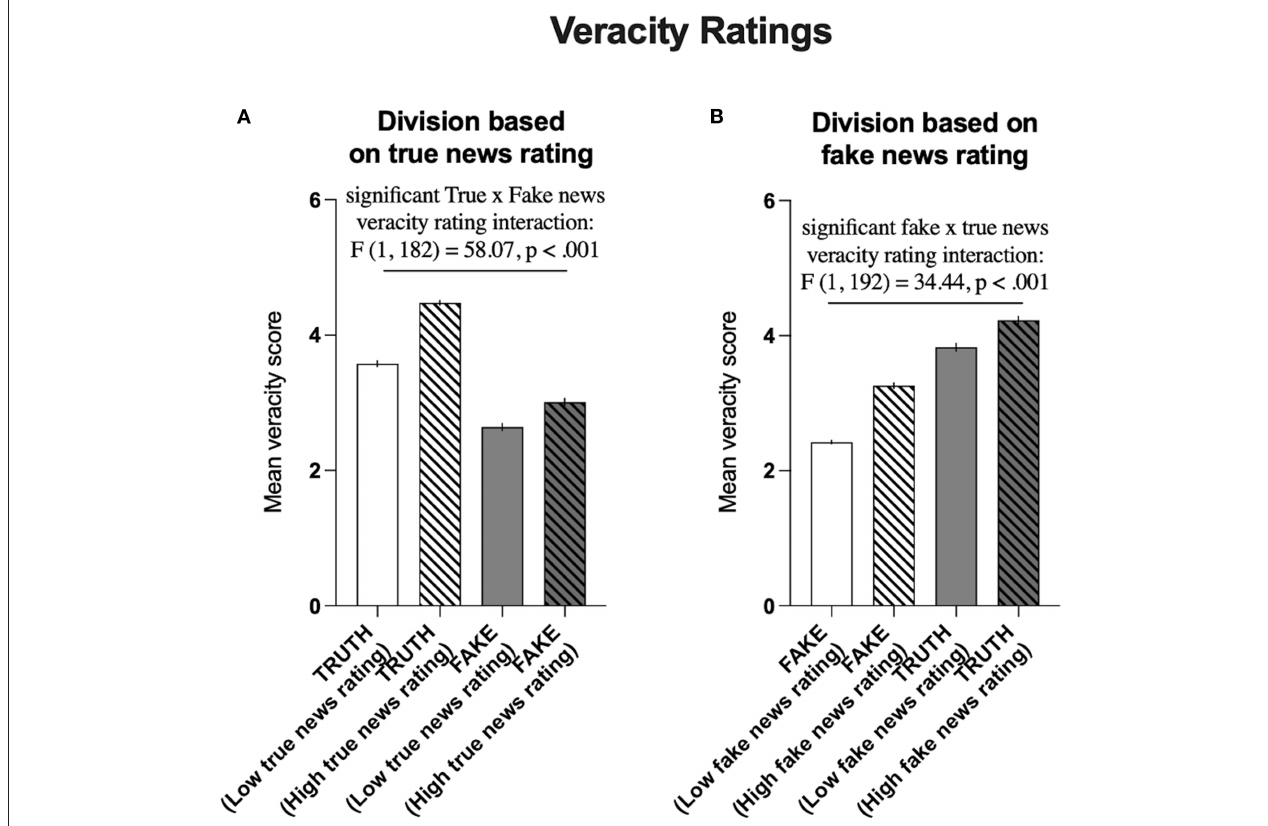
FIGURE 8 | Division based on the average true and fake news ratings. (A) Comparison of the average true news veracity ratings ( ) with the average fake news veracity ratings ( ) in groups that were differentiated based on the average low ( N = 93) and high true ( N = 91) news veracity ratings ( ). (B) Comparison of the average fake news veracity ratings ( ) with the average true news veracity ratings ( ) in groups that were differentiated based on the average low ( N = 96) and high ( N = 88) fake news veracity ratings ( ). The data are presented as AVG veracity ratings ±